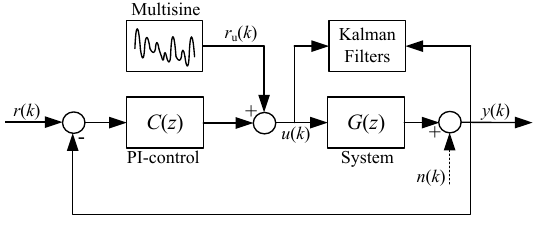
Figure 6: Scheme of the closed-loop identification.